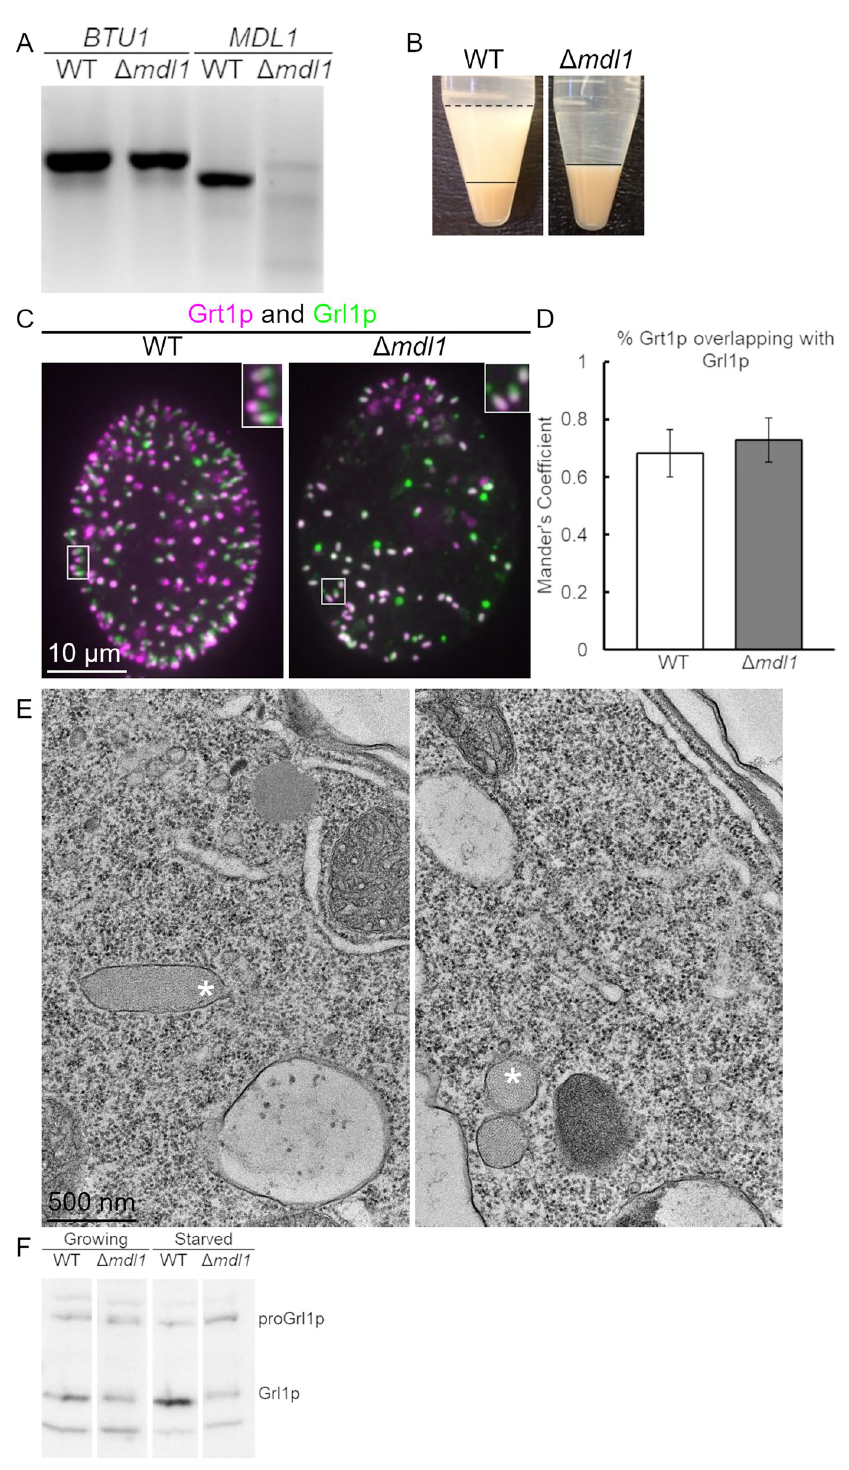
Fig 4. Analysis of Δ mdl1 cells. A. Δ mdl1 cells have no detectable MDL1 transcript. cDNAs from wildtype and Δ mdl1 were used as templates in PCR reactions with BTU1 -specific primers as a control (lanes 1,2), and with MDL1 -specific primers (lanes 3,4). The MDL1 -specific primers flank intron 5. B. Δ mdl1 cells are defective in induced mucocyst secretion. Equal numbers of wildtype and Δ mdl1 cells were stimulated with dibucaine. The cell pellet is smaller in the wildtype sample compared to the mutant because in the former some cells remain trapped in the flocculent layer. The